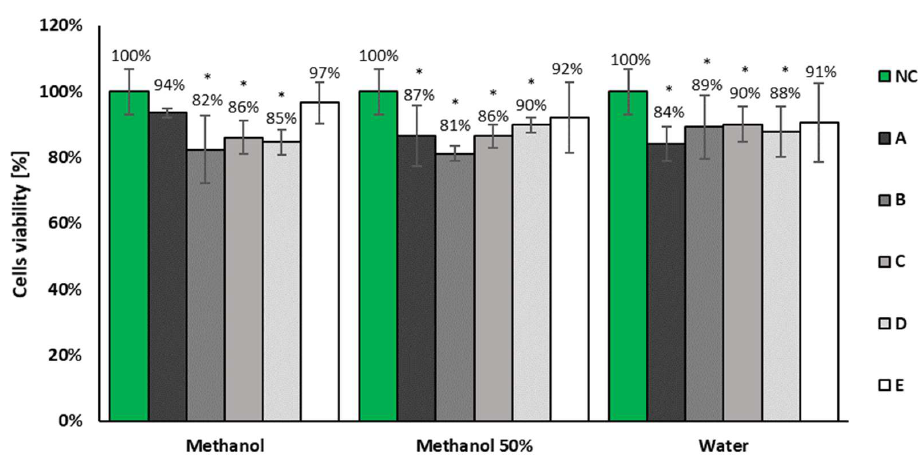
the strongest protective effect against CPZ-induced photogenotoxicity. A comparison of all the extracts tested at the same concentration (100 µ g/mL) using different solvents is shown in Figure 9.